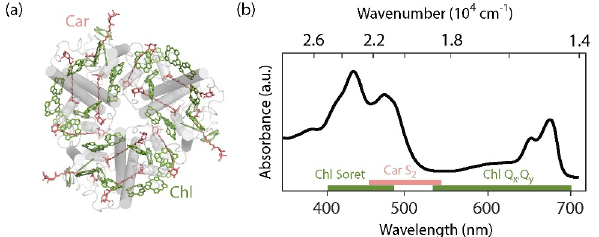
Fig. 1. (a) Structural model (top view) of a trimeric LHCII complex based on its crystal structure (PDB 1RWT). Chls are displayed in green, Cars are displayed in pink, and the protein matrix is shown in grey. (b) Linear absorption spectrum of LHCII. Coloured bars indicate the pigment transitions giving rise to the corresponding region of the